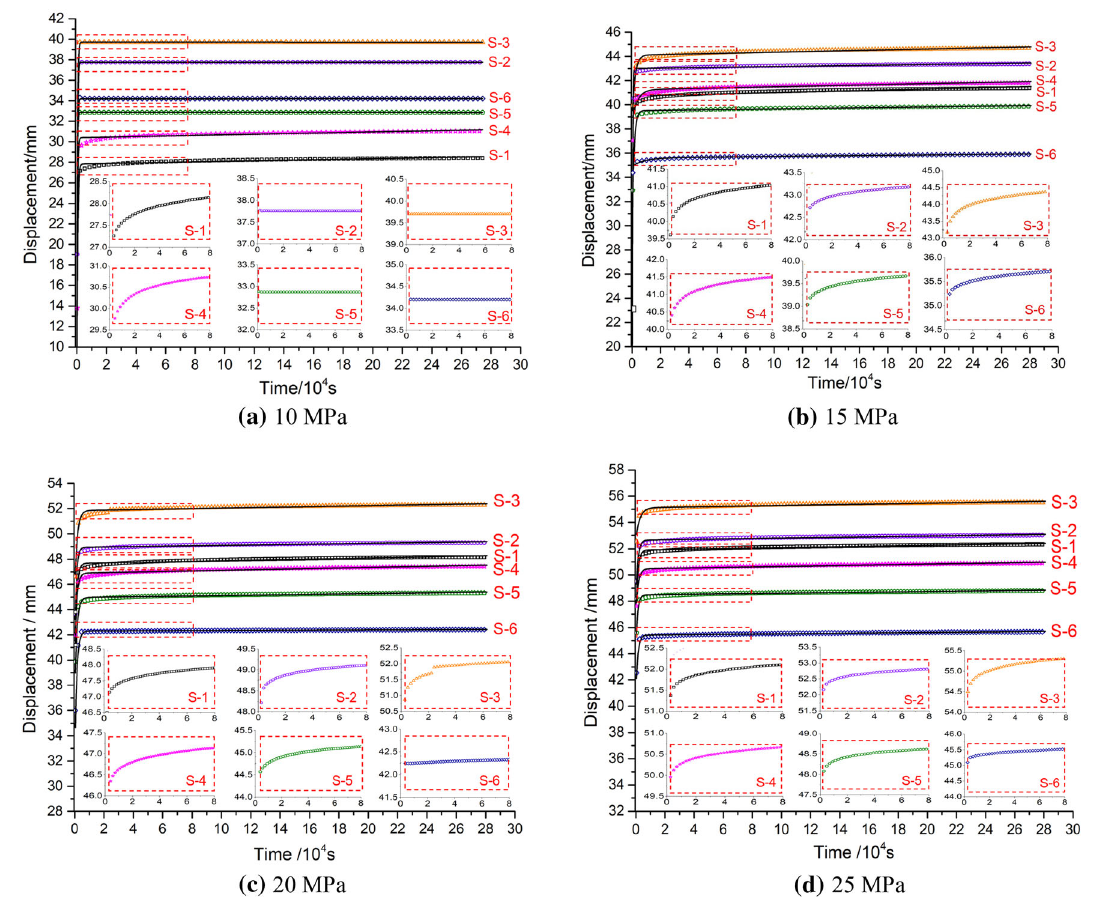
Fig. 9 The creep displacement–time curves of crushed mudstones under different axial